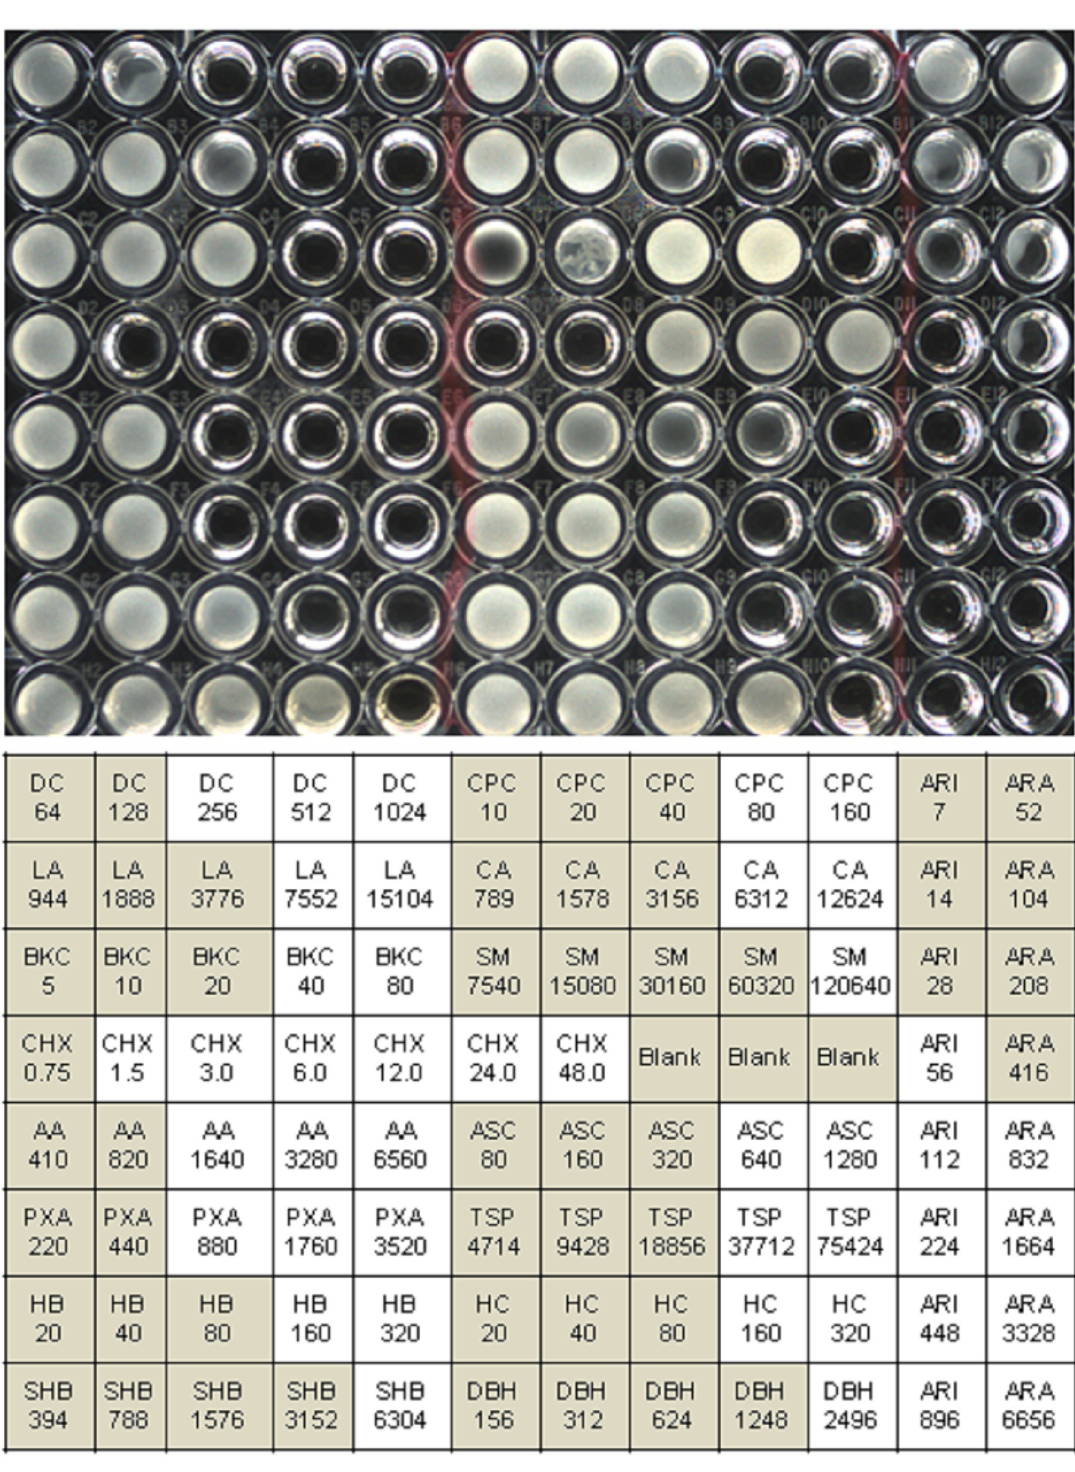
PLOS ONE | https://doi.org/10.1371/journal.pone.0209072 December20, 2018 5 /